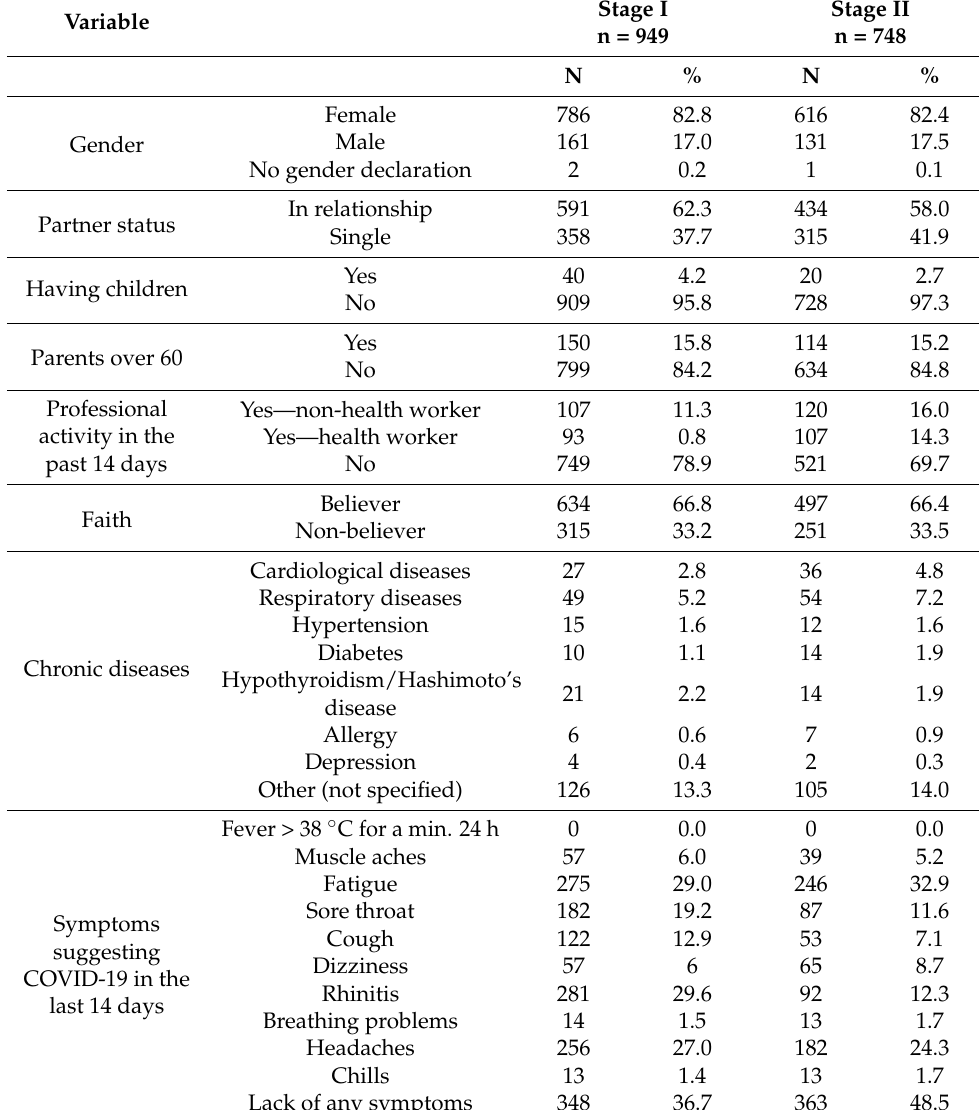
Table 1. Demographic and clinical characteristics of studied